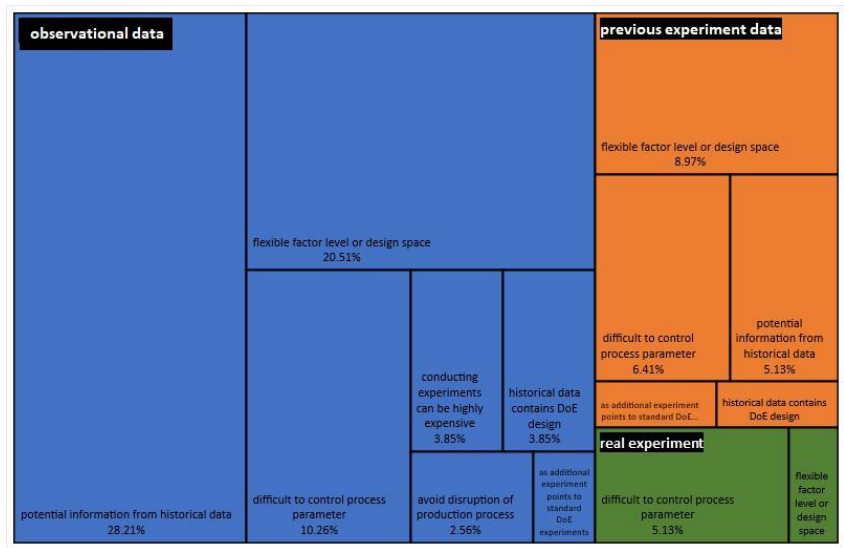
Figure 8. Distribution of the rationales based on data types.